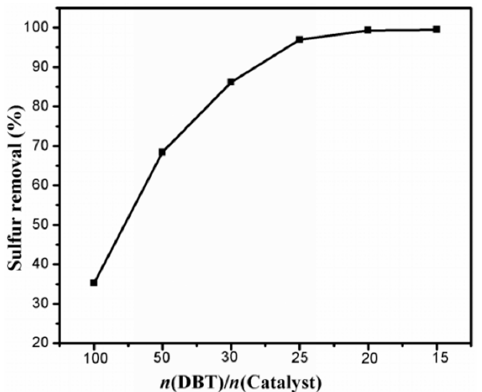
Figure 4. Influence of the amount of catalyst on the oxidative desulfurization of DBT. Conditions: Model oil = 5 mL, n (H 2 O 2 )/ n (DBT) = 5, T = 50 ◦ C for 60 min with [Bmim] 5 PMo 11 Co(H 2 O)O 39 as the catalyst and [Omim]BF 4 (1 mL) as the